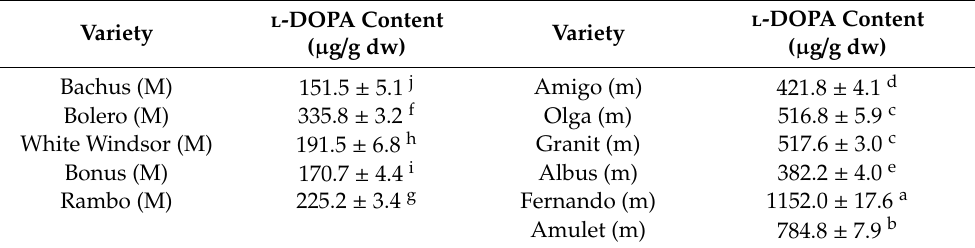
Table 4. l -DOPA amounts obtained after extraction A from dry beans of di ff erent varieties of V. faba var. major (M) and V. faba var. minor